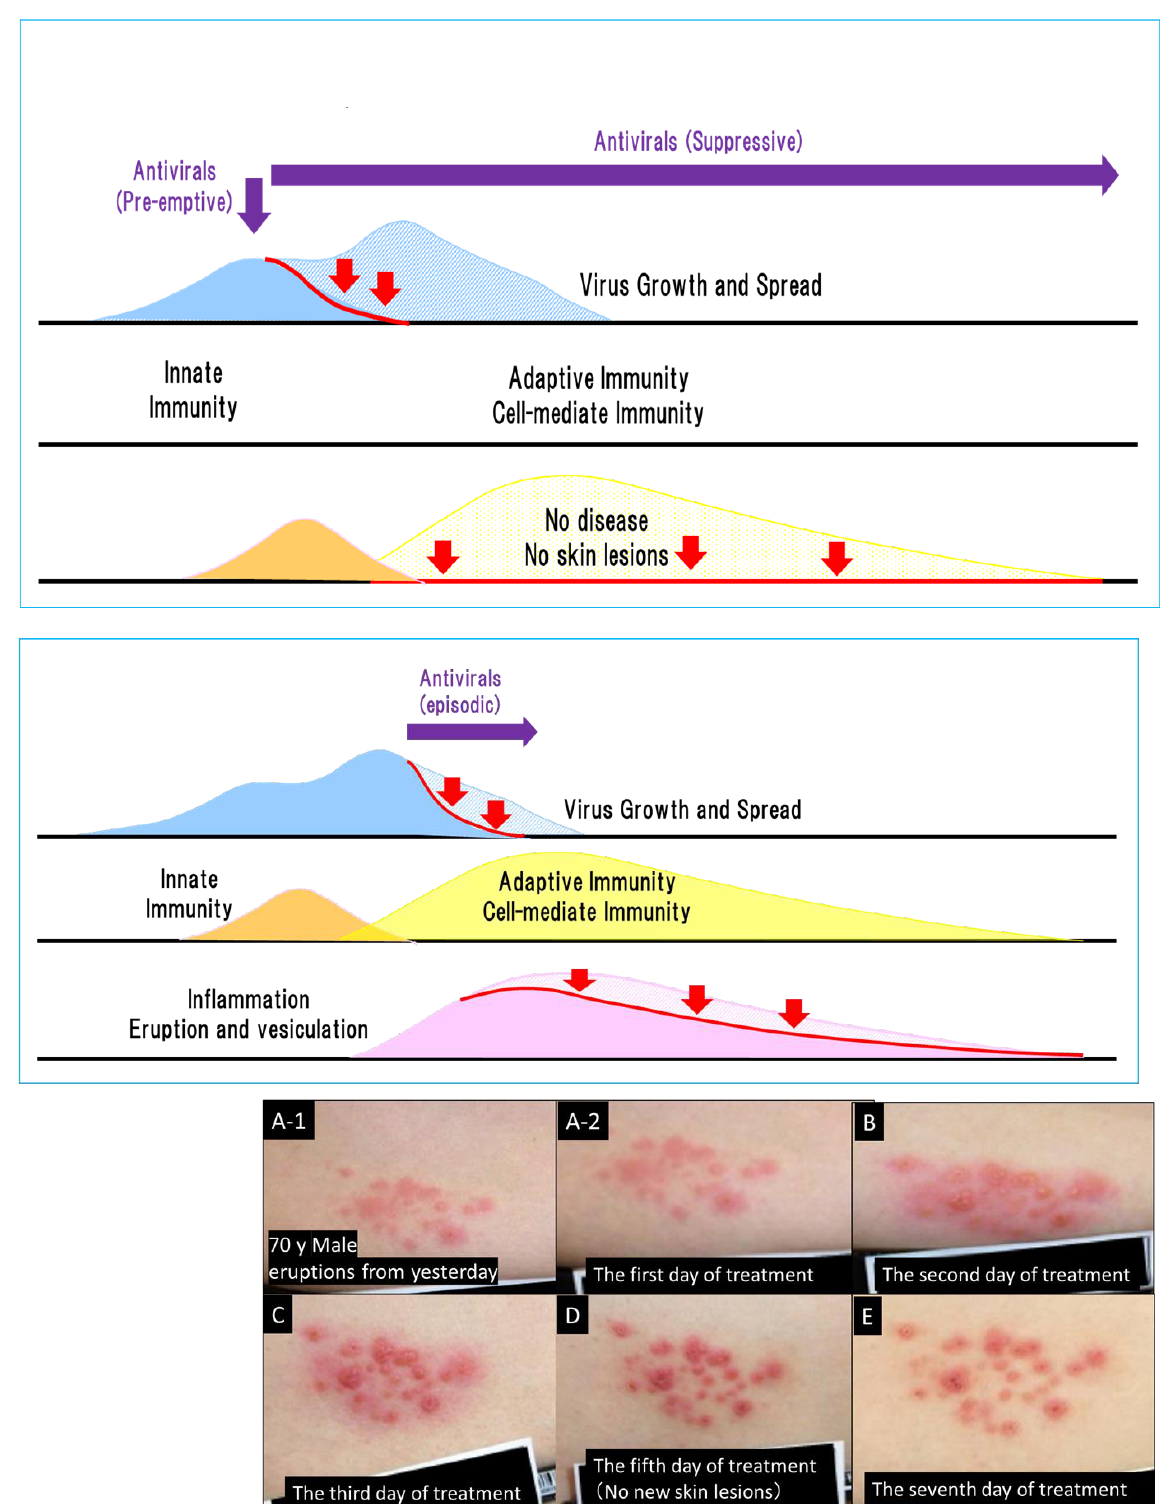
Figure 8. Antiviral treatment at the prodrome and after the onset of herpes zoster. Antiviral therapy inhibits virus growth and spread, as shown by the red arrows. Antiviral treatments started before the prodrome, which are susceptible to photodistribution, include suppressive therapy for HSV, preemptive therapy, and the latter half of the incubation period of varicella. These treatments prevent the onset of overt diseases, which prevents skin lesions. Once the overt disease has occurred, skin lesions continue for 1 week for HSV, 1 – 2 weeks for varicella, and 3 weeks for herpes zoster. Apparent deterioration of inflammation and improvement of herpes zoster lesions related to cell-mediated immune responses after the initiation of antiviral treatment. Photograph: A 70-year-old male patient noticed a rash on the left-hand side of his